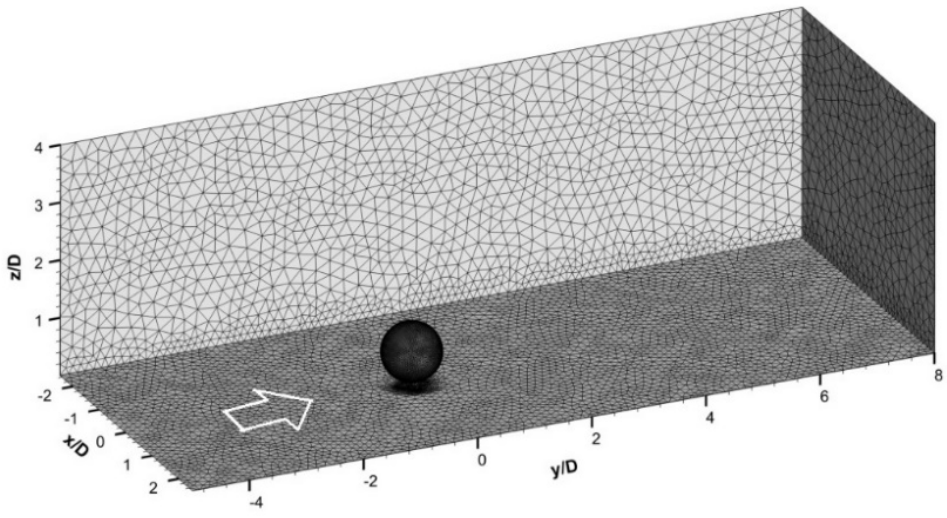
Figure 5. Computational domain and boundary mesh for sphere-scour simulation.